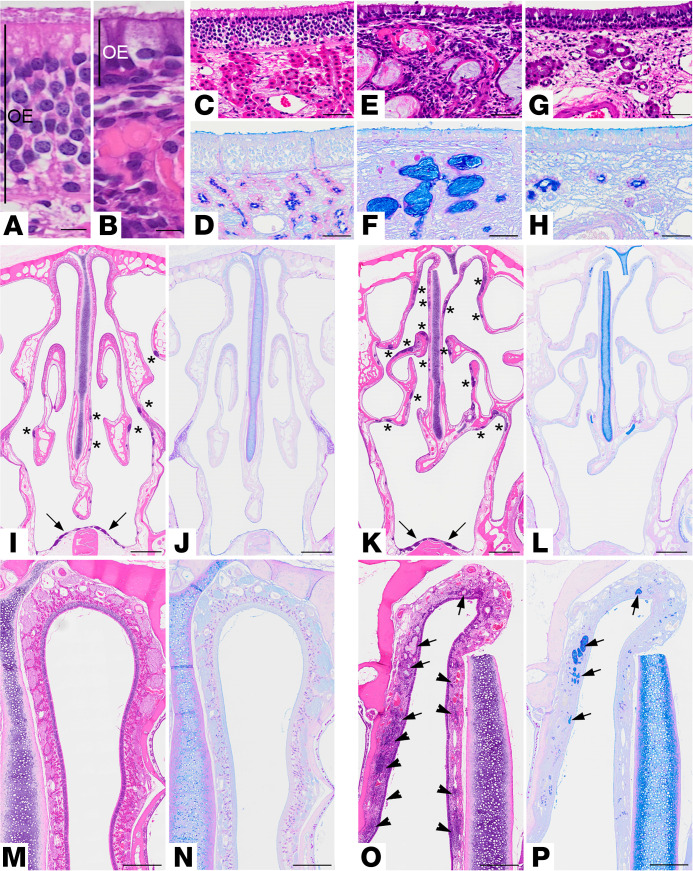
Functional deletion of CFTR in rabbit nose causes progressive remodeling of the olfactory and respiratory mucosa.(A–H) Representative high-power histological micrographs of WT (A, C, D) and CF (B, and E–H) olfactory mucosa stained with (H&E) (A, B, C, E, G) or AB-PAS (D, F, H). Scale bar: 10 μm (A and B), 50 μm (C–H). Note the striking degeneration of the olfactory epithelium in CF (B), which is reduced in height by approximately half, as compared with WT rabbits (A). OE, olfactory epithelium. Only sustentacular cells appear to remain on the CF surface epithelium. Degeneration of the olfactory epithelium is accompanied by impaction (E and F) and atrophy (G and H) of the underlying Bowman glands. Micrographs representative of n = 5 CF and WT rabbits, all ≥ 1 year old. (I–P) Lower magnification of histological micrographs of WT (I, J, M, and N) and CF (K, L, O, and P) rabbit posterior nasal cavity stained with H&E (I, K, M, and O) or AB-PAS (J, L, N, and P). Scale bar: 2 mm (I–L) and 0.5mm (M–P). I–L illustrate the increased number of ectopic lymphocytic aggregates (asterisks) in CF as compared with WT rabbits. Nasal-associated lymphoid tissue (NALT, arrows) was visible in the ventral aspect and do not appear different in the 2 genotypes. M–P highlight the extent of pathological changes in the nasal cavity of CF rabbit ≥ 1 year old, including remodeling of submucosal glands underlying the olfactory epithelia (O and P, arrows) and lymphocytic inflammation in the airway epithelial submucosa (O, arrowheads).